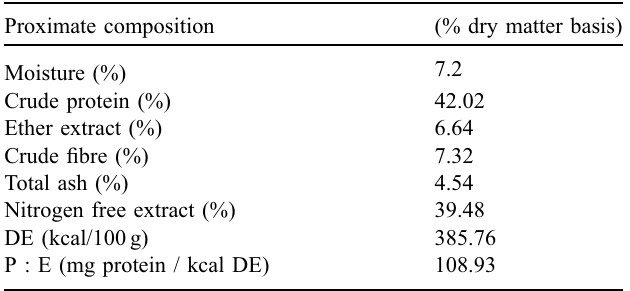
Table 2. Proximate composition of commercial feed used for L.